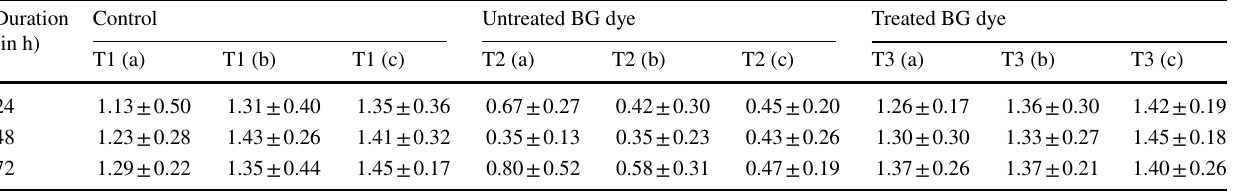
(Results are the mean value ± standard deviation with significant difference at P